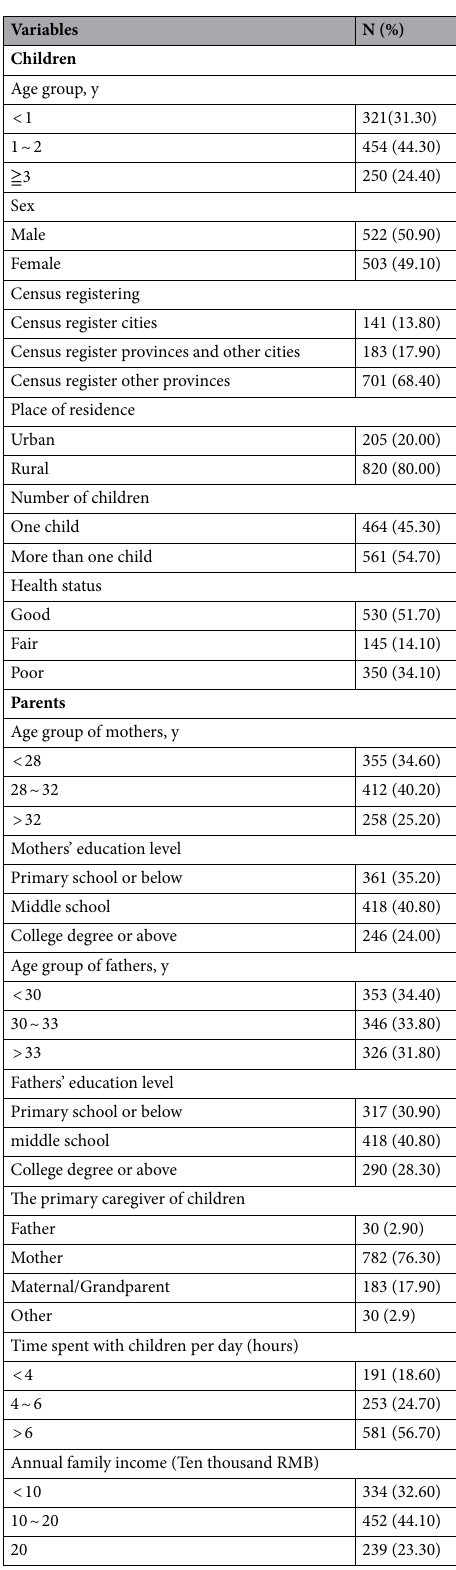
Table 1. Study characteristics of children and their